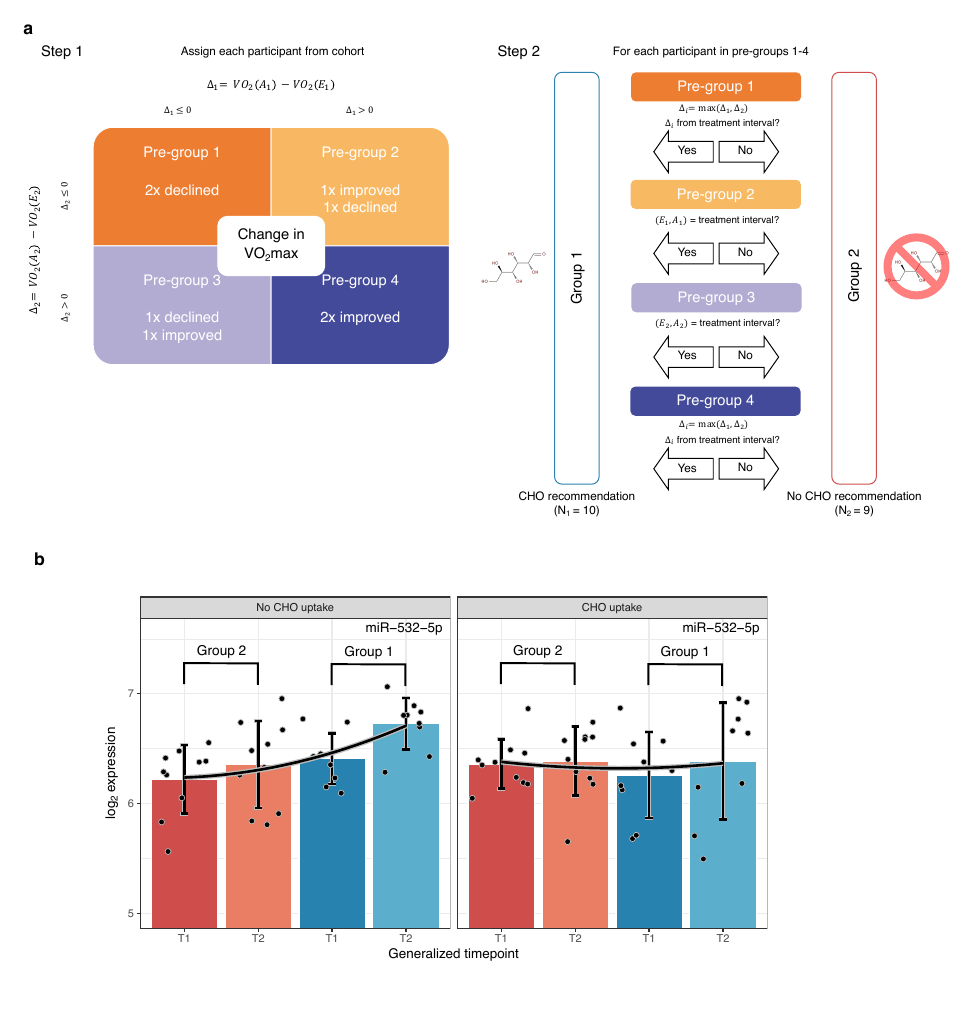
Figure 6. Assignment procedure conducted to find CHO recommendation groups and group-wise expression of candidate marker miR-532-5p. ( a ) Schematic workflow of devised procedure to classify each participant p into one of the two recommendation groups r ( p ) ∈ { 0,1 } . The decision process primarily depends on the personal change in VO 2 max values during the first training period, ∆ = VO ( A ) − VO ( E ) and ∆ = VO ( A ) − VO ( E ) from the second training period. In a 2 2 2 2 2 2 2 1 1 1 second step, participants are assigned to exactly one of the two recommendation groups based on which interval the better ∆ VO 2 occurred; ( b ) Paired barplots showing the expression of miR-532-5p across training period timepoints, i.e., T 1 ∈ { E 1 , E 2 } and T 2 ∈ { E 2 , A 2 } , compared between the two CHO treatment recommendation groups, once using training periods without and once with an oral administration of glucose. Recommendation groups are highlighted by distinct colors where blue corresponds to a positive and red to a negative recommendation on glucose uptake. Each black point belongs to one sample in the distribution. Bar heights display the mean expression values and black error bars mean ± standard deviation. Smoothed quadratic b-splines ( b = 2) are drawn as black curves with a contrast